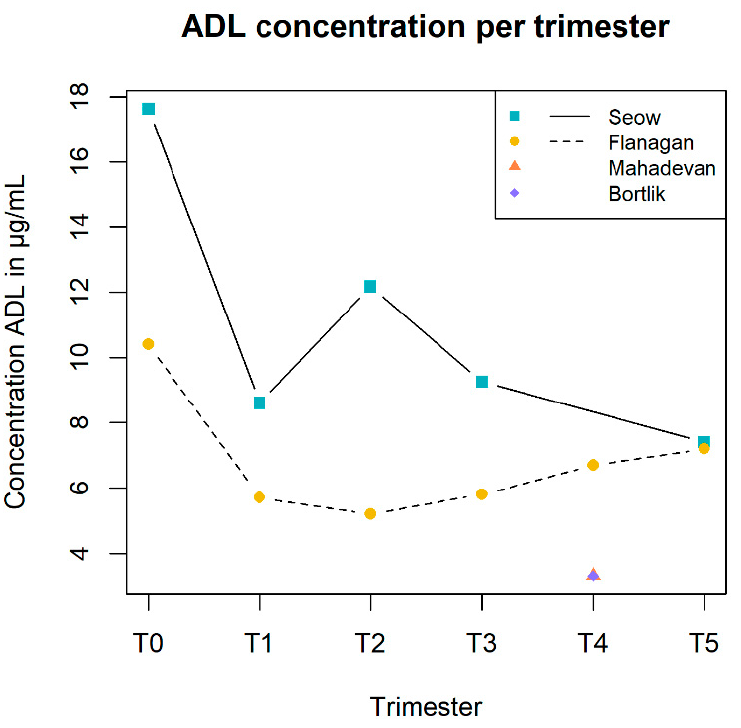
Figure 5. The concentrations of adalimumab (ADL) from all available studies [14,15,19,20] in µ g/mL (on the y -axis) during the different stages of pregnancy (on the x -axis). The different states are expressed as pre-pregnancy (T0), trimesters one until three (T1, T2 and T3), delivery (T4) and postnatal (T5).